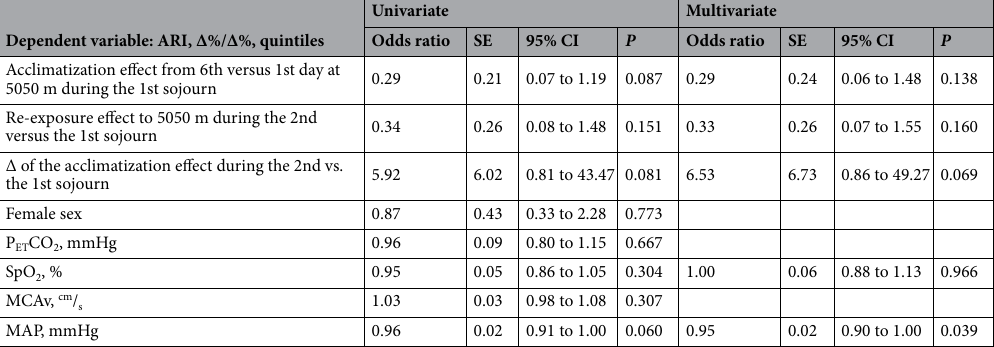
Table 4. Predictors for cerebral autoregulation at 5050 m assessed by mixed ordered logistic regression models. N = 18 measured at 4 different time points (1st sojourn: 1st and 6th day at 5050 m; 2nd sojourn: 1st and 6th day at 5050 m). To account for the low number of observations (a total of 53 observations due to single missing values), the 5 most significant predictors from the univariate regression were entered into the multivariate regression model. Odds ratio represent the odds to change from one to the next higher ARI quintile by changing one unit of the independent predictor. Higher/Lower ARI quintiles represent worse/ better cerebral autoregulation. P ET CO 2 = partial pressure of exhaled carbon dioxide, SpO 2 = oxygen saturation measured by finger pulse oximetry, MCAv = middle cerebral artery peak velocity, MAP = mean arterial pressure, ARI = autoregulation